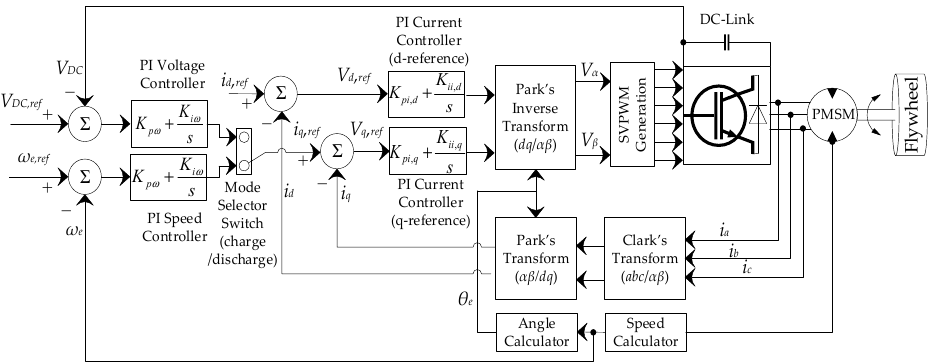
Figure 5. Block diagram of flywheel energy storage systems (FESS) controlling scheme.